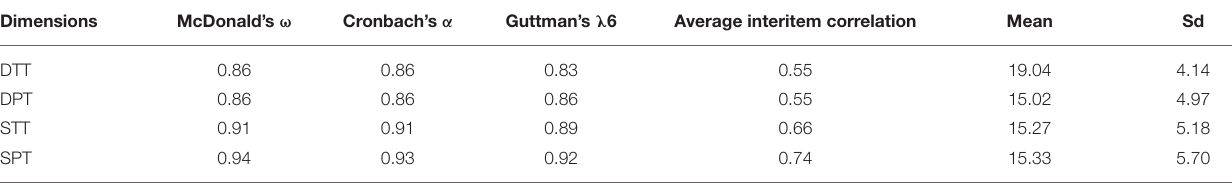
TABLE 2 | Internal consistency of the PE-SPQ.